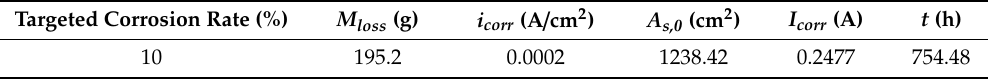
Table 2. Targeted corrosion rate, power, and